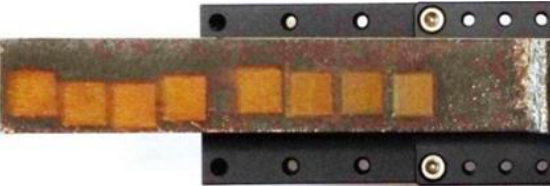
Figure 5. Specimen for residual stress measurement. Table 1. Mechanical property and chemical composition. Mechanical Proper- Chemical Compositions (%) ties